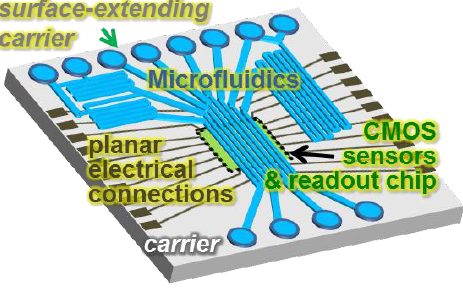
Figure 18. Concept of lab-on-CMOS integration of CMOS biosensors and multichannel microfluidics using a carrier device and planar electrical interconnections.